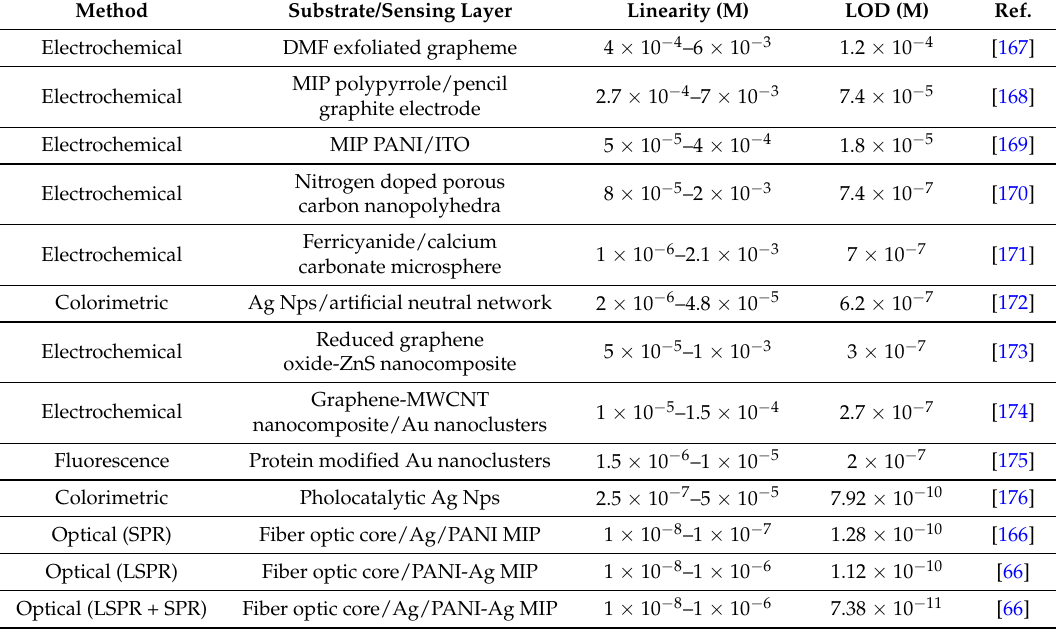
Table 2. Linearity and detection limits of various AA detection methods: Reprinted with permission from [66]. Copyright 2016 Institute of